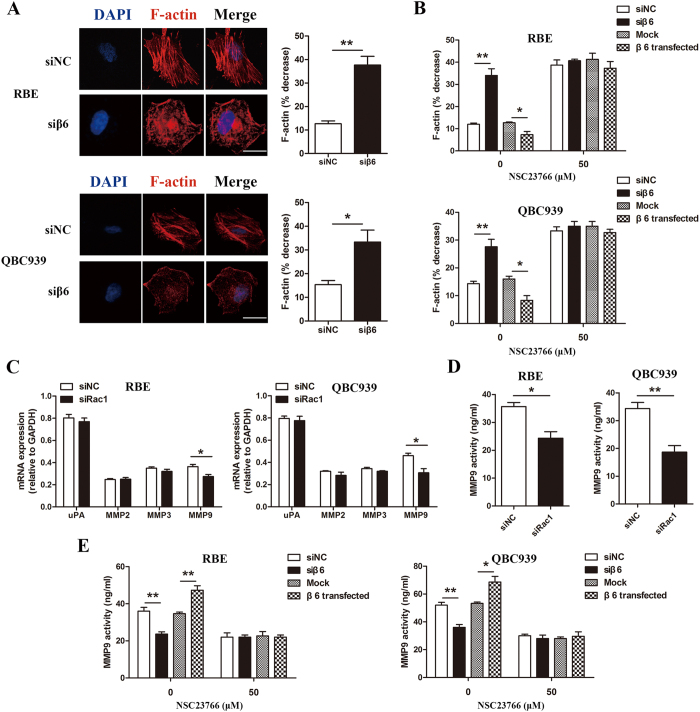
Integrin β6 induced F-actin polymerization and MMP9 expression by activating Rac1.(A) After transfection of β6 siRNA, F-actin in RBE and QBC939 cells was stained by TRITC-conjugated phalloidin and observed with laser confocal microscopy. The % decrease in F-actin = [(F-actin in untreated cells–F-actin in NC or β6 siRNA treated cells)/F-actin in untreated cells] ×100. Scale bar, 10 μm. (B) After treatment with NSC23766, RBE and QBC939 cells were transfected with β6 siRNA or β6-overexpressing plasmid, and F-actin was stained by TRITC-conjugated phalloidin and observed with laser confocal microscopy. (C) MMP9 mRNA expression was significantly decreased in RBE cells and QBC939 cells after transfection with Rac1 siRNA, while the expression of uPA, MMP2 and MMP3 showed no significant changes. (D) The protein level of MMP9 was detected by ELISA in RBE and QBC939 cells after Rac1 silencing. (E) The protein level of MMP9 was detected by ELISA in RBE (C) and QBC939 cells (D) pretreated with NSC23766 and β6 siRNA or β6-overexpressing plasmid. Data represent the mean ± SD from three independent experiments. *P < 0.05; **P < 0.01.